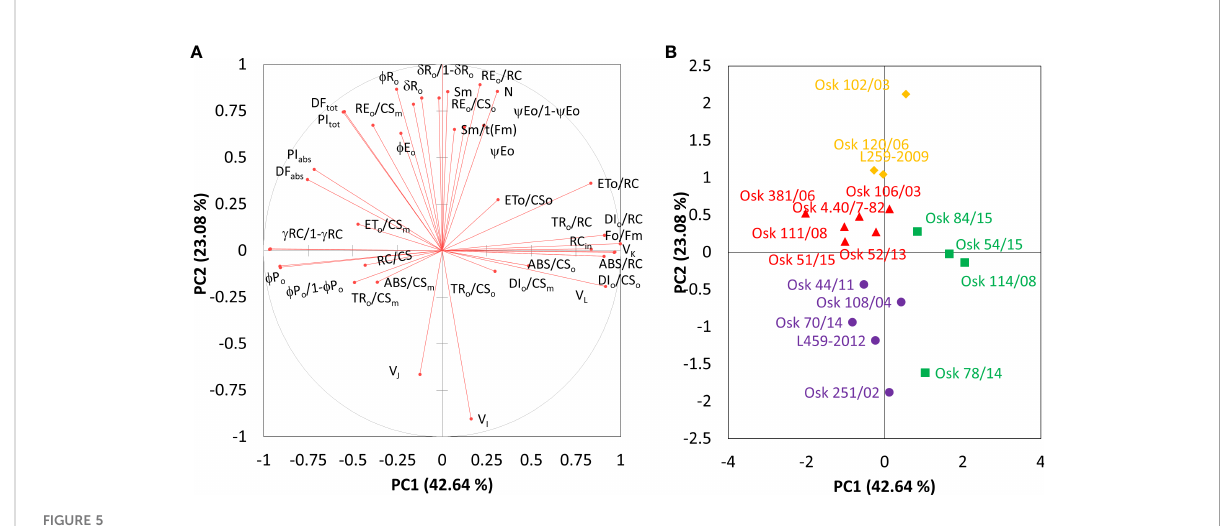
FIGURE 5 Principal component analysis of chlorophyll a fl uorescence parameters derived as the mean difference between PEG-induced drought treatment and control samples for 18 winter wheat cultivars. Correlations between obtained parameters and the two principal components (A) and projections of genotypes (B) with only centroids that are displayed and sorted by hierarchical cluster analysis ( (cid:129) Cluster 1, ◼ Cluster 2, ▲ Cluster 3, ♦ Cluster